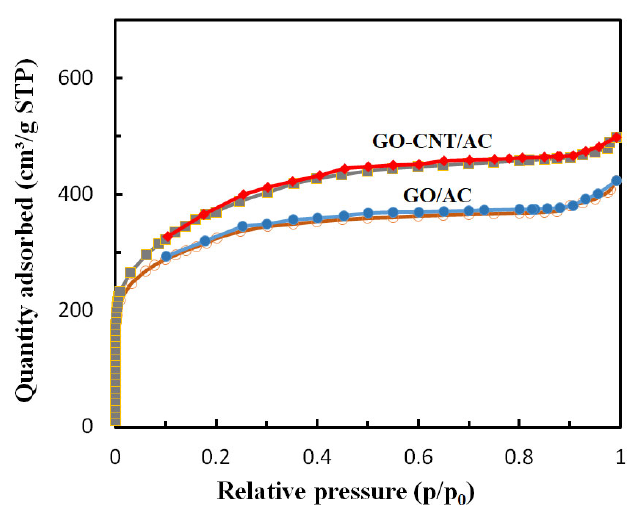
Figure 6. N 2 adsorption–desorption isotherms of the GO/AC and GO ‐ CNT/AC composites.